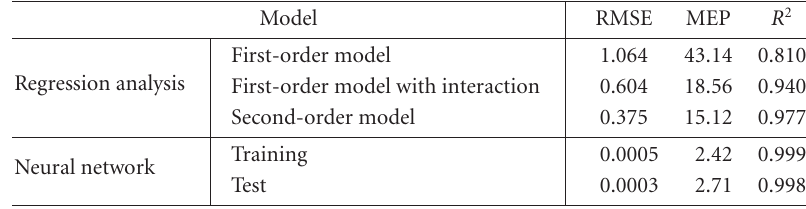
Table 15: Comparison of accuracy values of